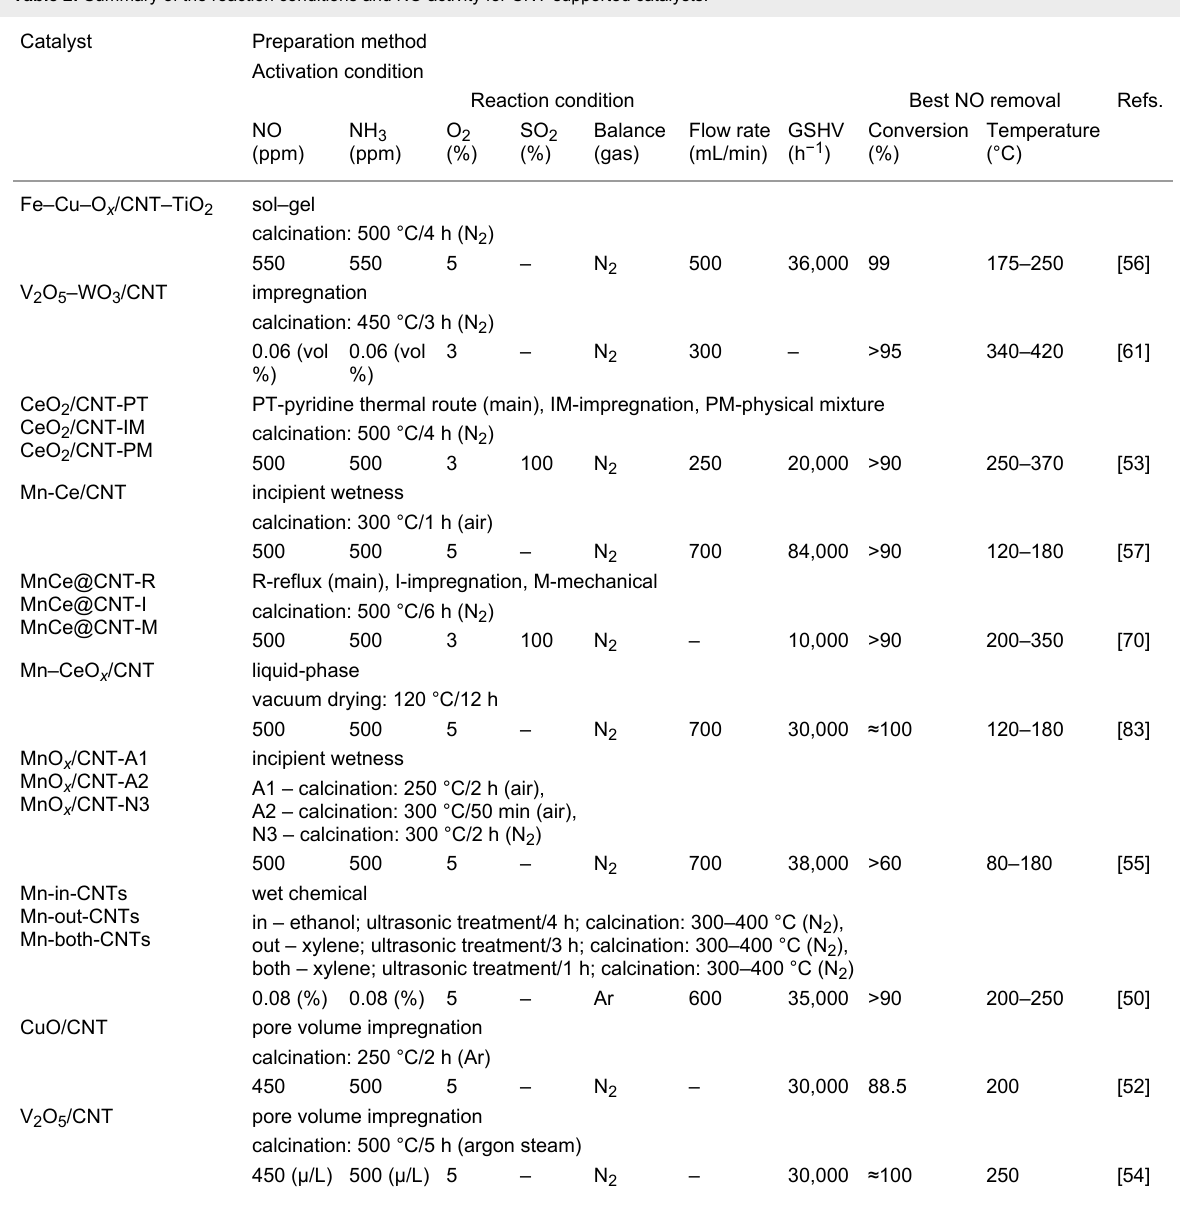
Table 2: Summary of the reaction conditions and NO activity for CNT-supported